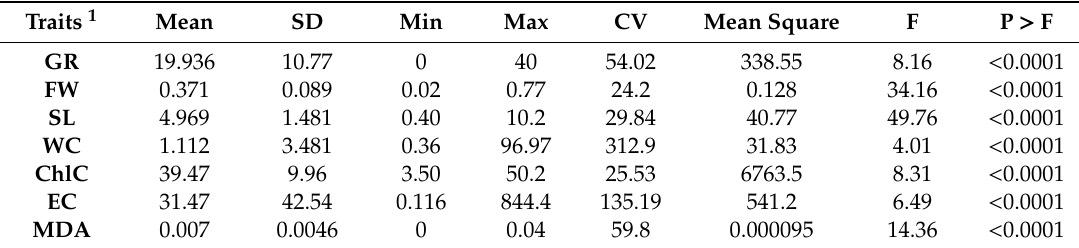
Table 1. Analysis of the traits related salt treatment in G. arboretum accessions.